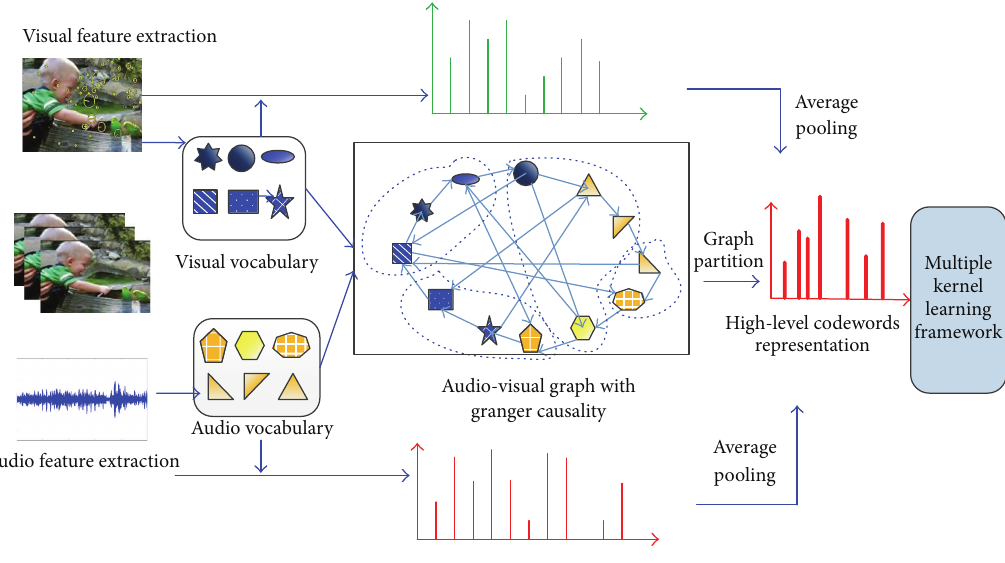
Figure 2: Flowchart of the proposed